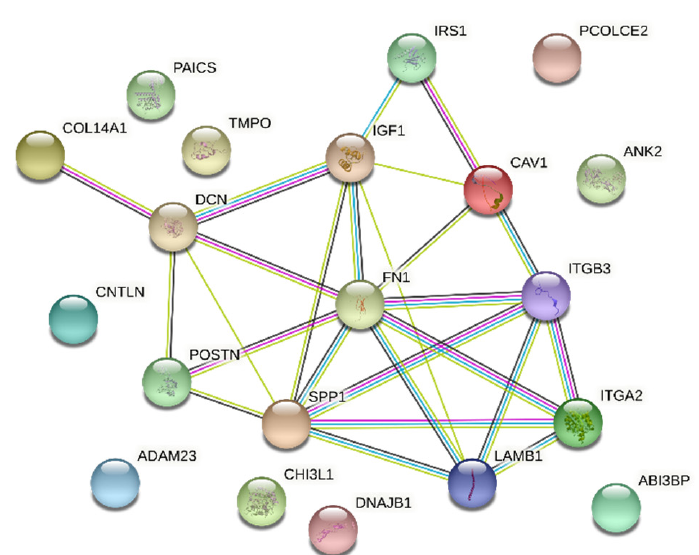
Figure 7. STRING-generated interaction network among 20 chosen differently expressed genes belonging to the “extracellular matrix binding”, “extracellular matrix structural constituent”, “binding, bridging”, “cadherin binding”, “cell adhesion molecule binding”, “collagen binding” and “cadherin binding involved in cell-cell adhesion” GO MF terms. The strength of the interaction score was reflected by the intensity of the edges.